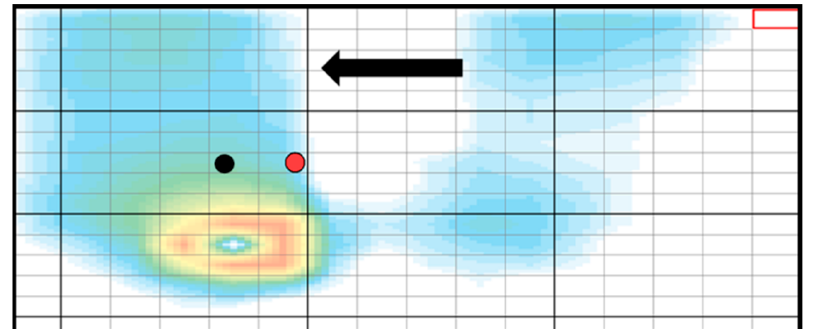
Figure 2. Center of pressure (COP) when moving in the direction of the arrow. The black circle indicates the actual COP and the red circle indicates the apparent COP (delayed COP).